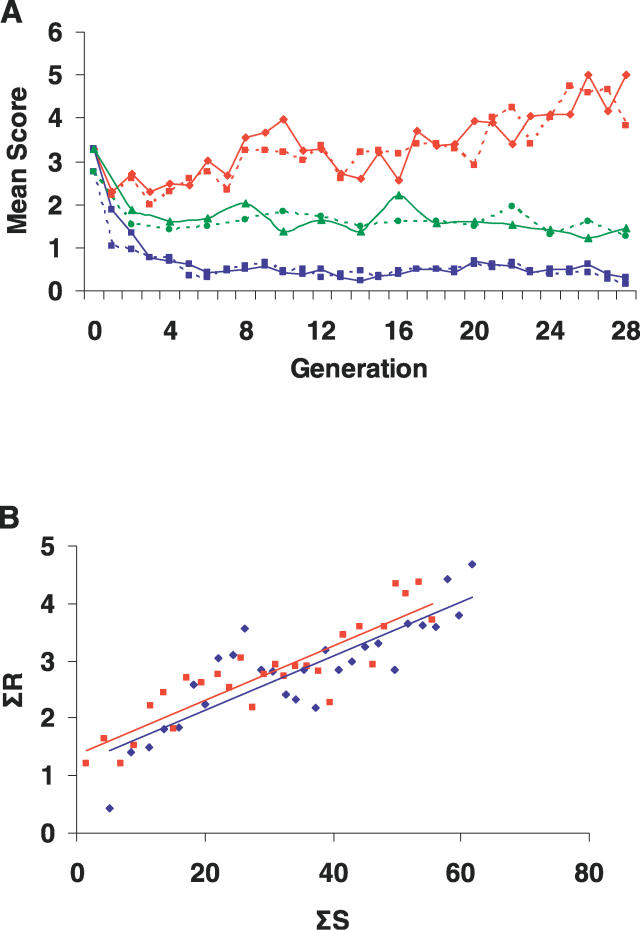
Phenotypic Response to Selection for Aggressive Behavior(A) Mean aggression score of selection lines. Squares () indicate L lines; triangles (▴) indicate C lines; diamonds (♦) indicate H lines; solid lines indicate Replicate 1; and dashed lines indicate Replicate 2.(B) Regressions of cumulative response on cumulative selection differential for divergence between high and low selection lines. Diamonds (♦) and blue line indicate Replicate 1; squares () and red line indicate Replicate 2.